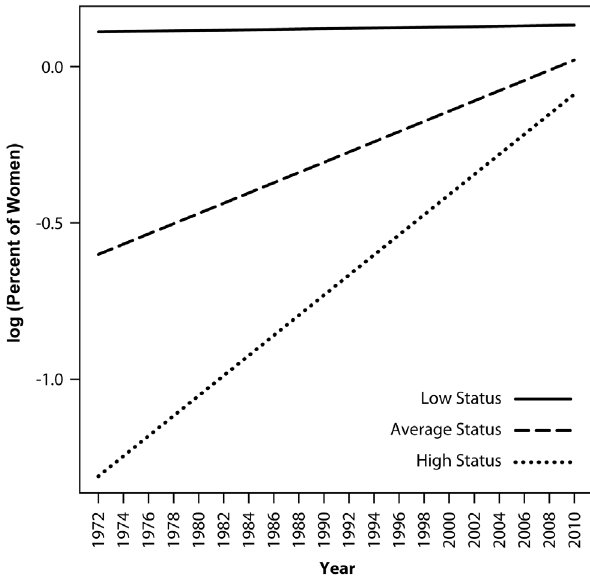
Figure 2. Simple slope plots of percent of women in low, average, and high-status occupations in MLM Model 1. Low- status occupations were defined as one SD below the mean, average- status occupations as at the mean, and high-status occupations as one SD above the mean status level of all occupations. Status was defined in terms of occupations’ median income levels.